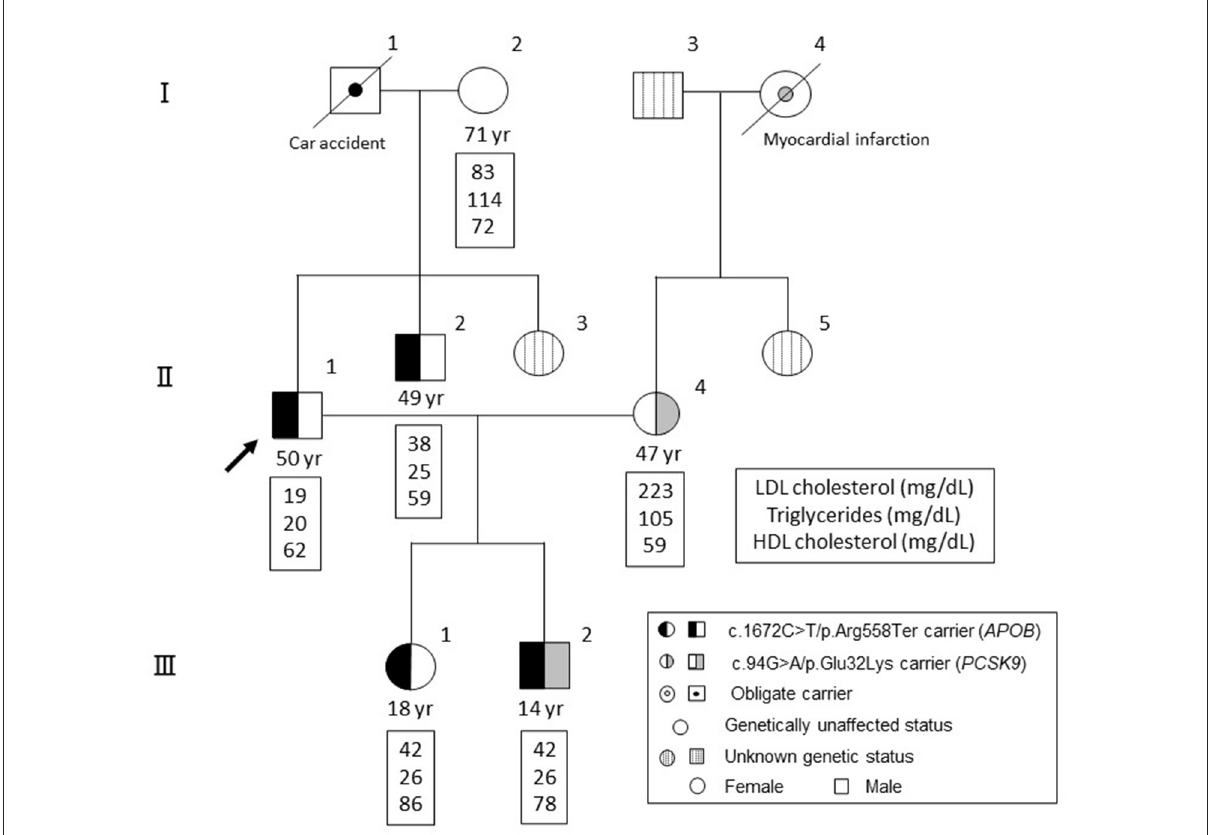
FIGURE1 Family tree. Black denotes individuals with a mutation in APOB (c.1672C > T/p.Arg558Ter). Gray denotes individuals with a mutation in PCSK9 (c.94G > A/p.Glu32Lys). Circles indicate females, whereas squares indicate